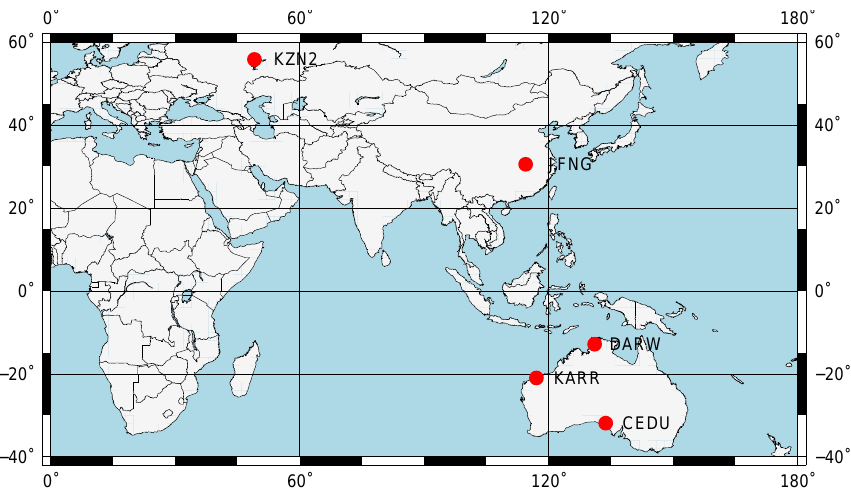
Figure 1. Distribution of the stations used in this experiment.